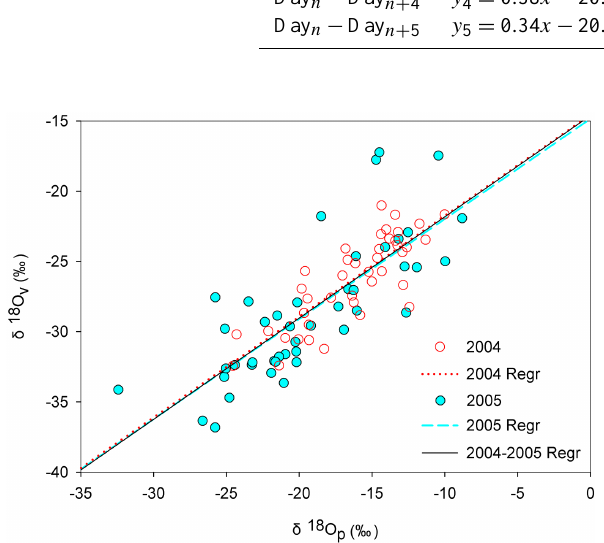
Figure 3. Relationships between δ 18 O p of precipitation and δ 18 O v of water vapour at Nagqu. Note that the values in 2004 are shown as red open circles; the values in 2005 are shown as blue solid